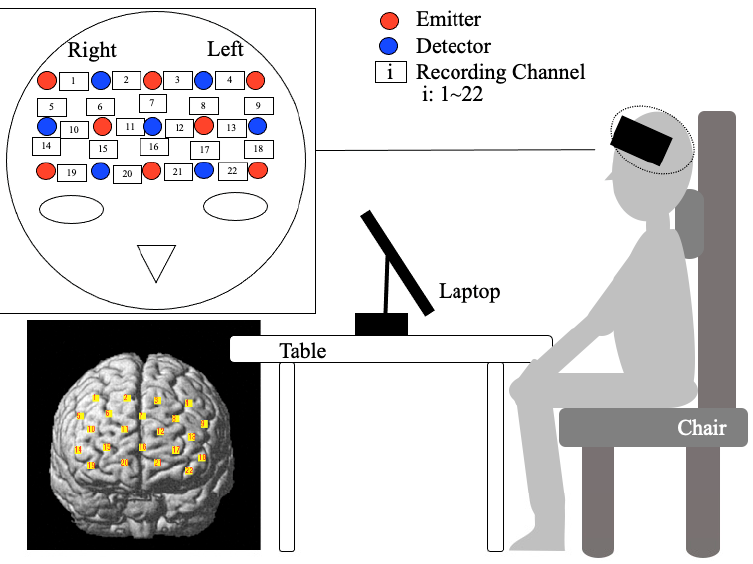
Figure 2. Arrangement of sensor array and 22 channels above the prefrontal cortex.